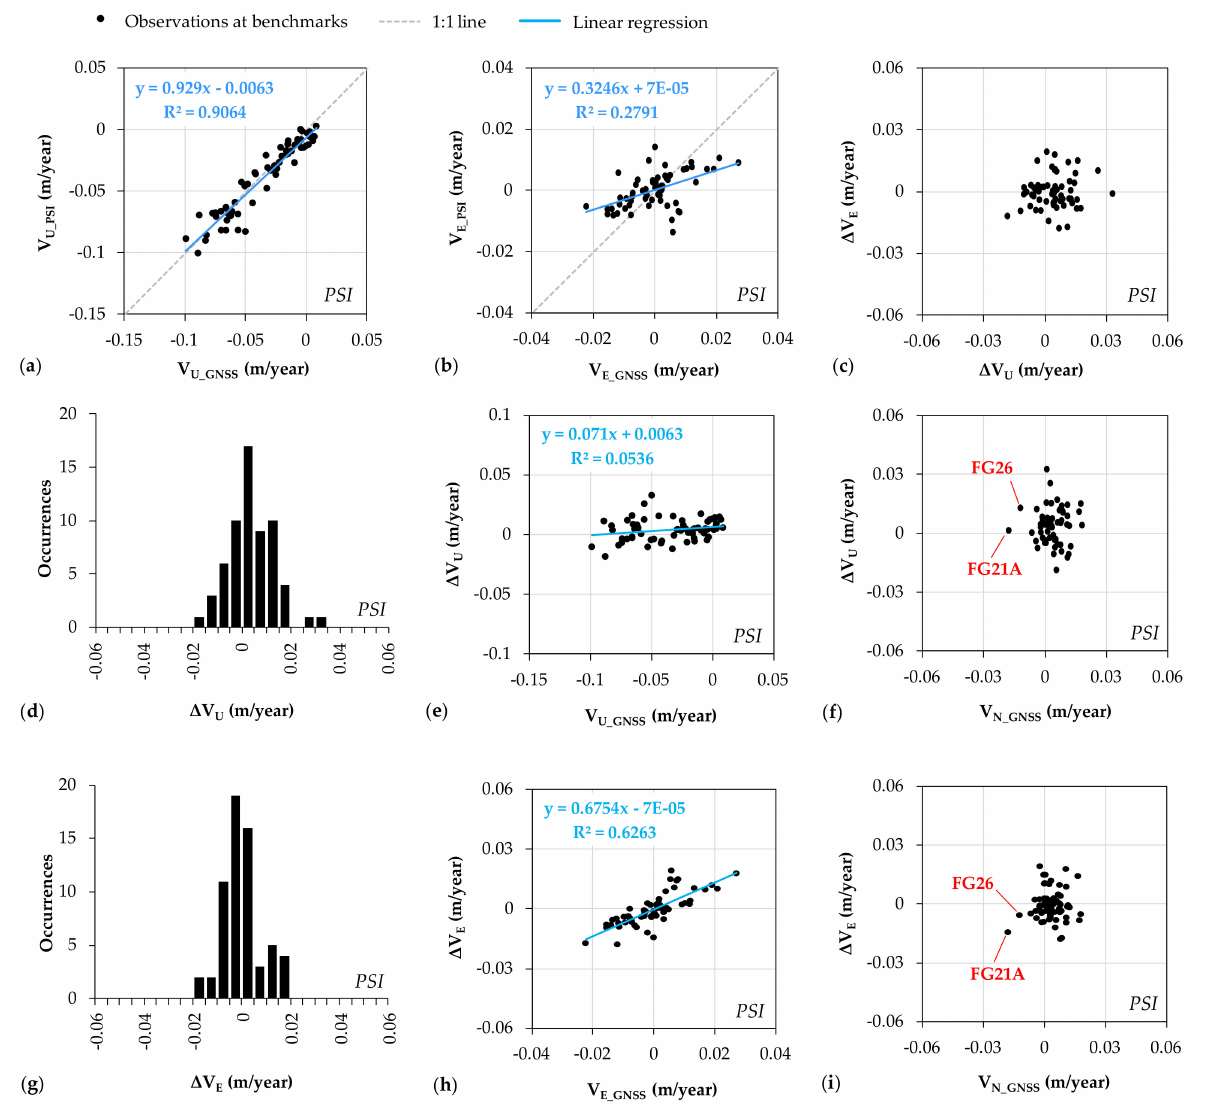
Figure 13. Comparison of the displacement velocity along the ( a ) vertical V U and ( b ) east-west V E direction as estimated from the PSI InSAR analyses and recorded at the permanent GNSS stations and GNSS benchmarks. The observed differences ∆ V ∆ V U and E were further investigated through ( c ) inter-comparison, ( d , g ) analysis of the respective histograms, and ( e , f , h , i ) their distribution in relation to GNSS